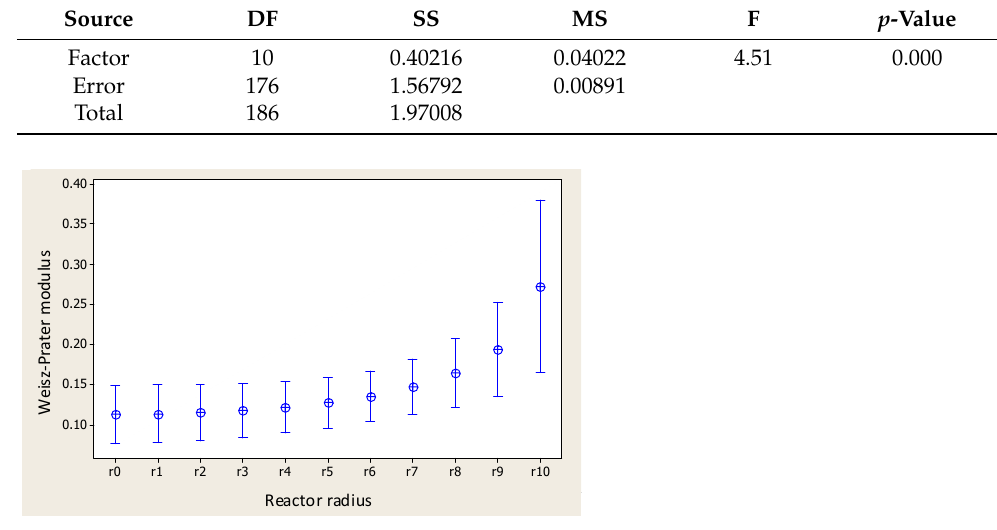
Figure 9. Weisz–Prater modulus vs. reactor radius (obtained from Table A4). Interval plot 95% CI for the mean. Table 6. Analysis of variance of the Weisz–Prater modulus versus the reactor radius.